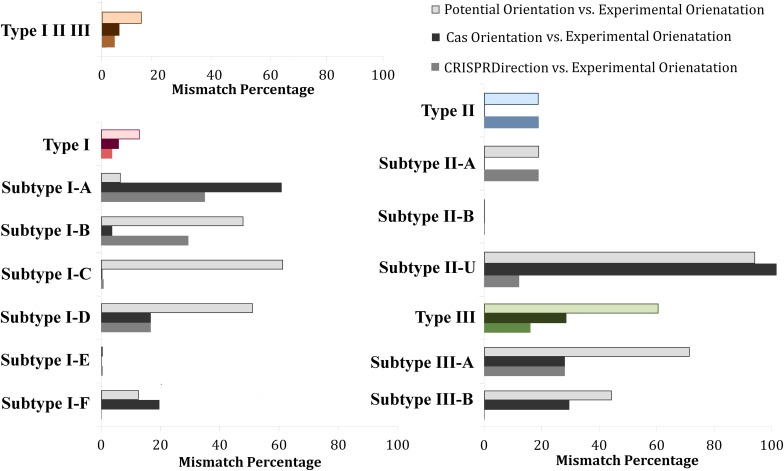
Distribution of mismatches between the investigated predictors (Potential Orientation, Cas Orientation, and CRISPRDirection) vs. Determined Orientation Set across different CRISPR/Cas types and subtypes. Every CRISPR/Cas type (along with corresponding subtypes) was denoted with a different color, red corresponding to Type I, blue to Type II, and green to Type III systems. The entire dataset (Type I, Type II, and Type III) was denoted with an orange bar plot. For each type, the gray-scale (printable) version of Potential Orientation (light shade), CRISPRDirection (moderate shade) and Cas Orientation (dark shade), correspond to the shades indicated in the figure legend. Note that II-U in the figure (labeled in accordance with CRISPRCasFinder notation), in fact corresponds to the subtype II-C.